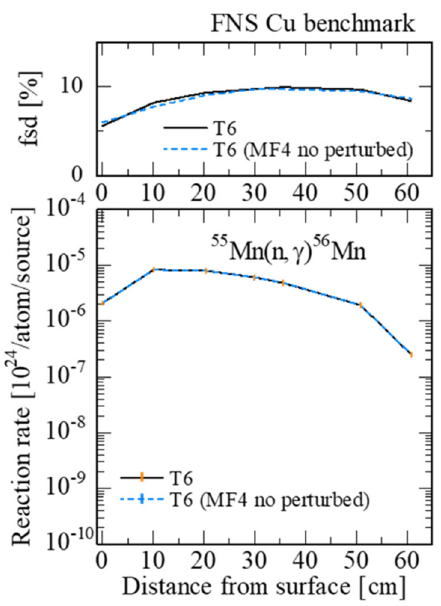
Fig. 10. Comparison of 55 Mn(n,  ) 56 Mn reaction rate distribution and the standard deviation between T6 and the result ignoring perturbation of angular